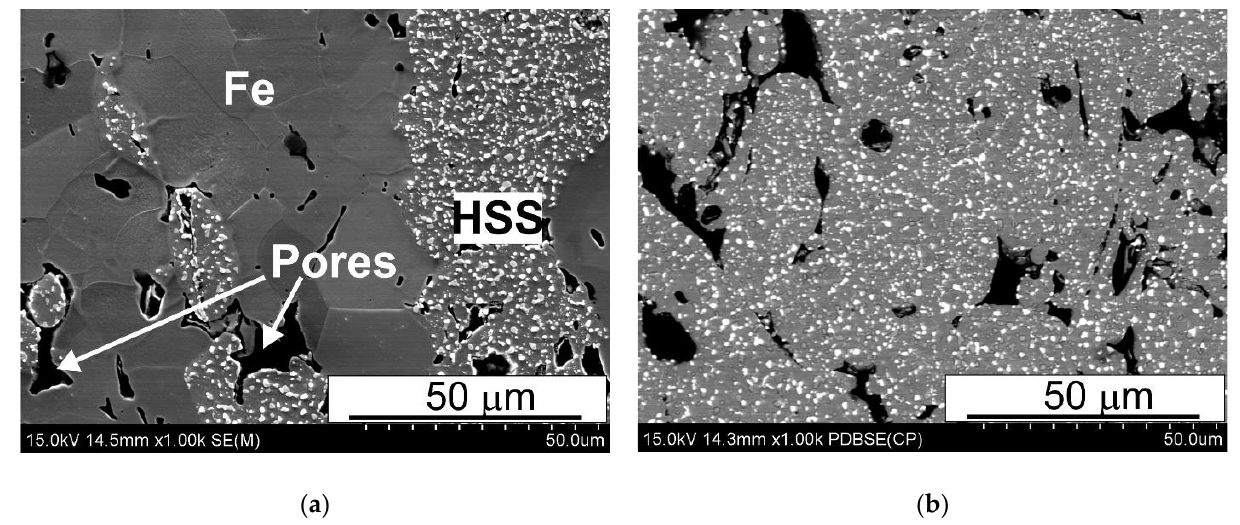
Figure 6. Microstructures of ( a ) T15+50%Fe and ( b ) T15 materials spark plasma sintered at 950 °C; SEM.